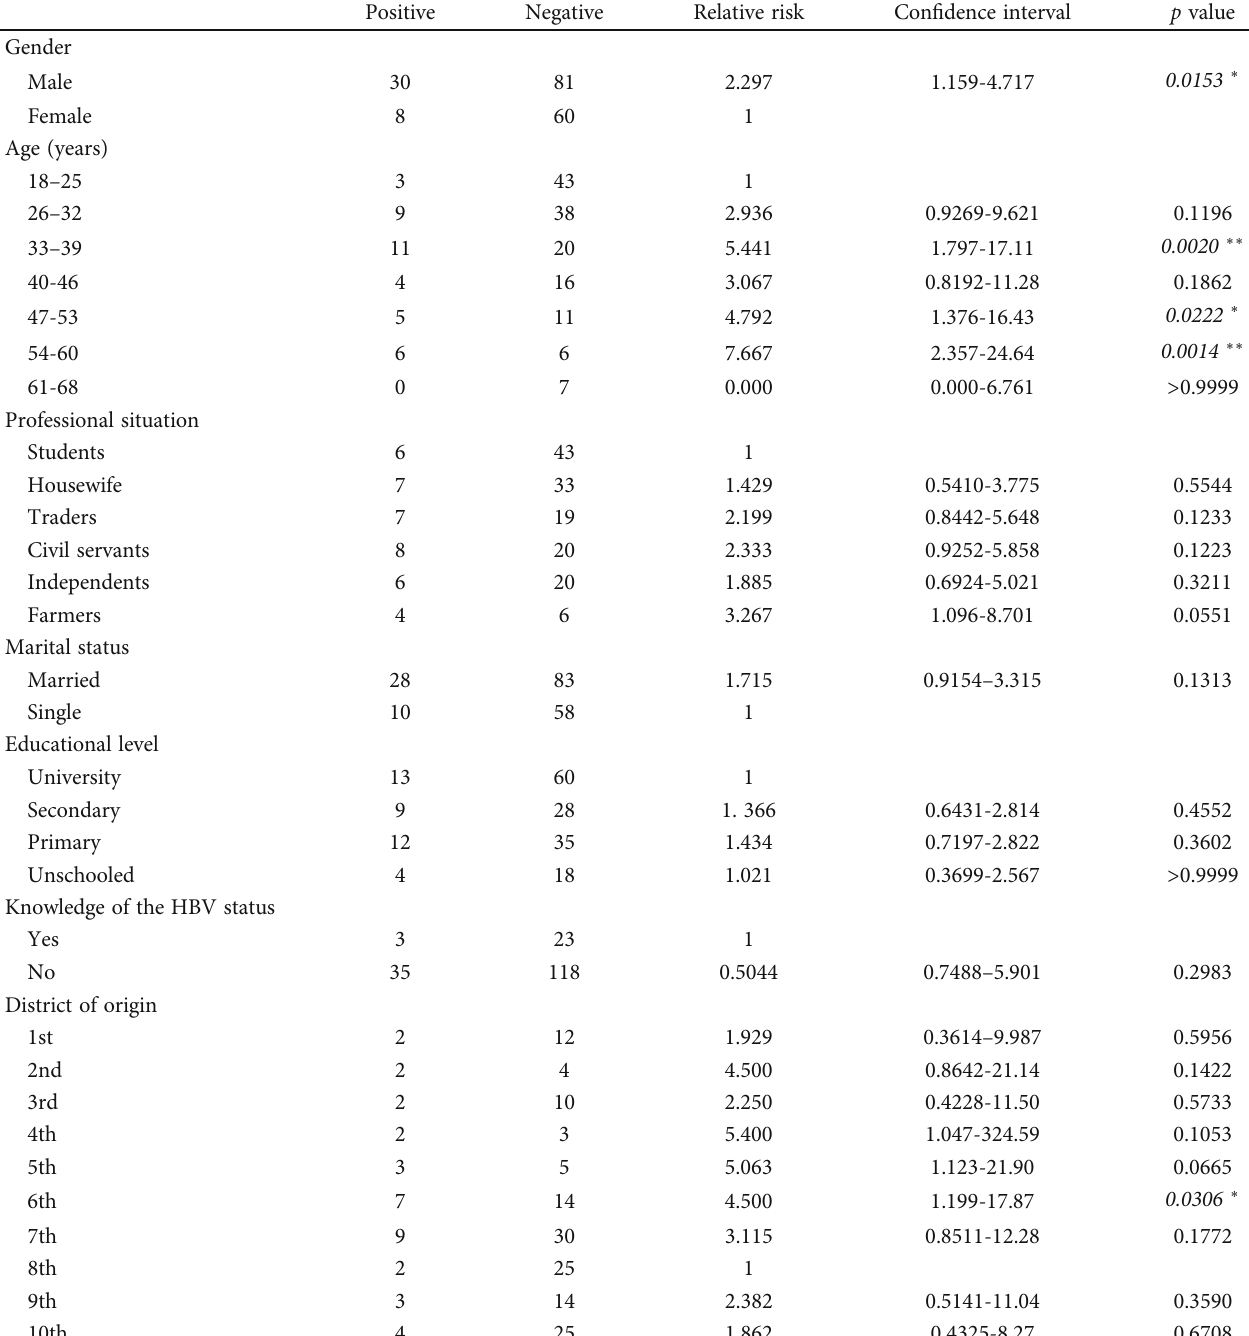
Table 2: E ff ect of the sociodemographic factors on HBV